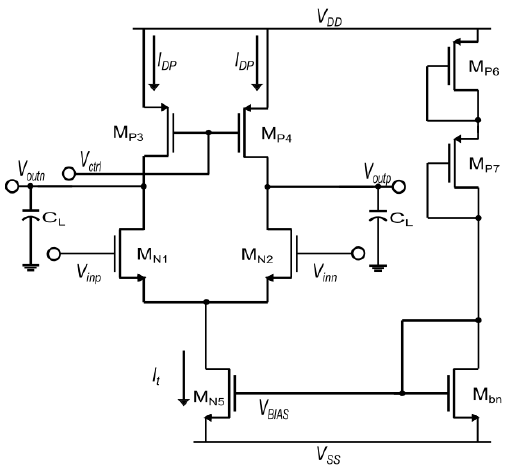
Figure 5. CMOS differential stage with active load and voltage control.